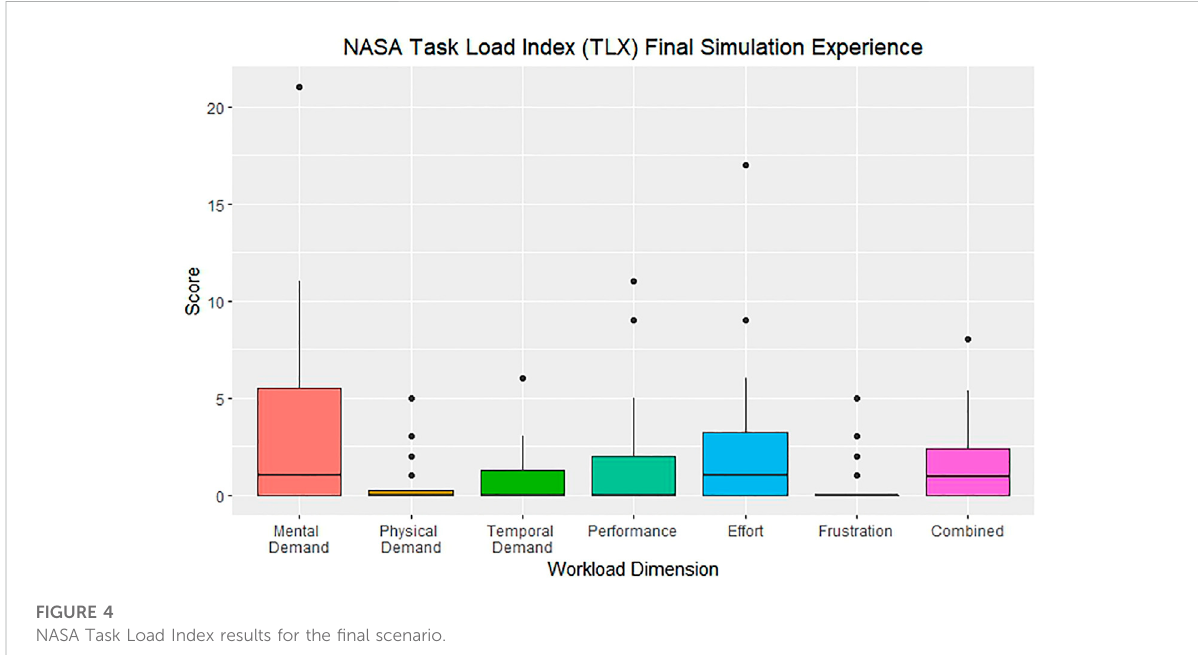
FIGURE 4 NASA Task Load Index results for the fi nal scenario.